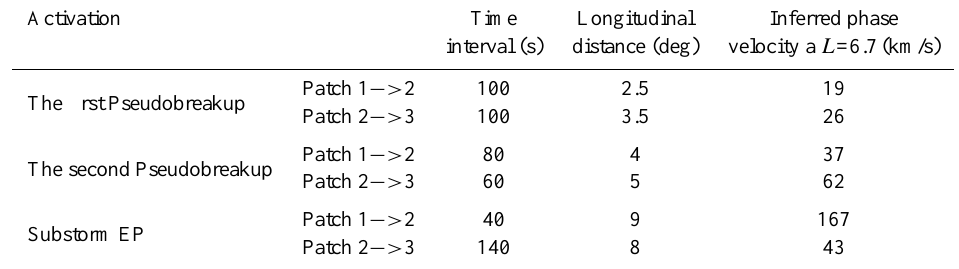
Table 2. Time interval and longitudinal distance of discrete auroral patches and the inferred phase velocity at geosynchronous